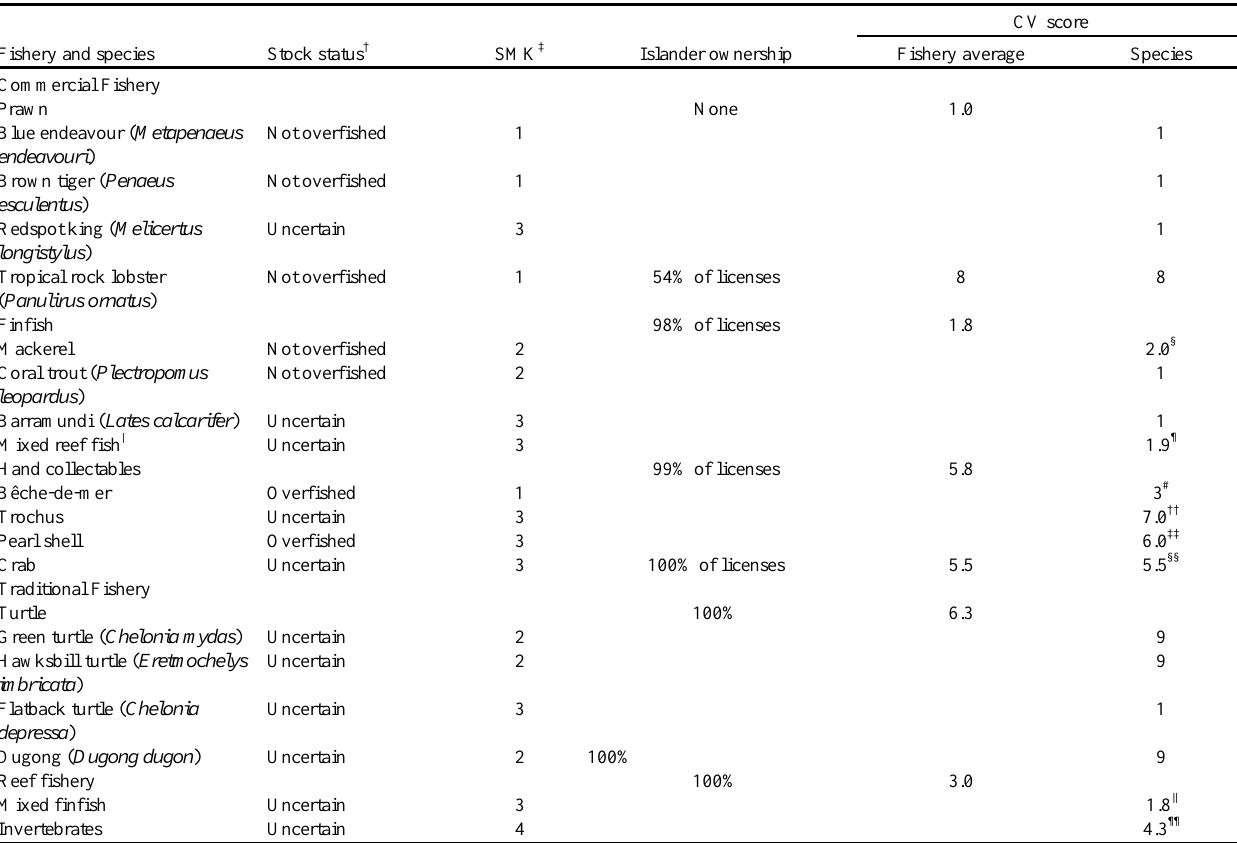
Table 3 . Stock status, science and management knowledge (SMK), and cultural value (CV) scores for commercial and traditional fisheries and species in the Torres